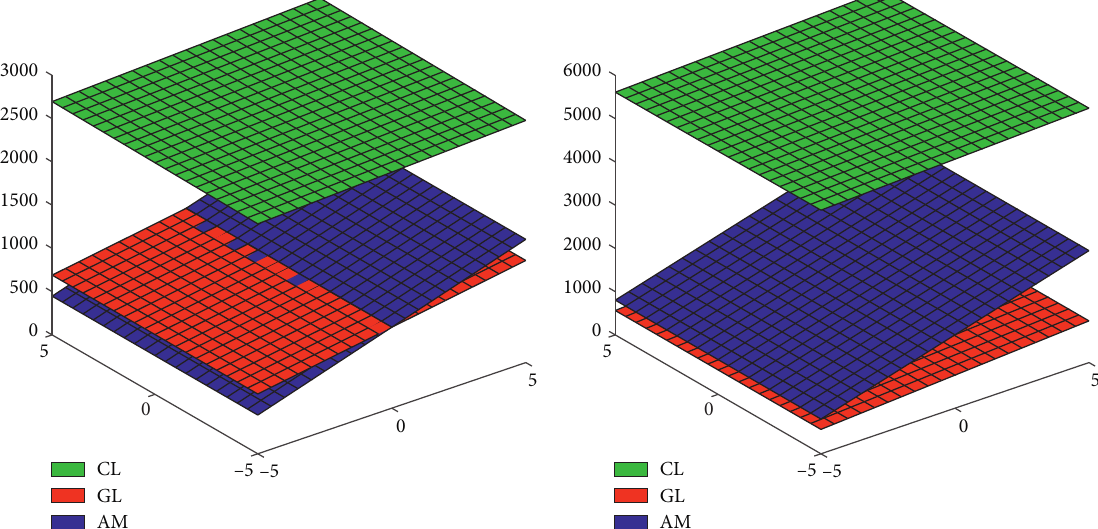
Figure 13: Comparison of CL l